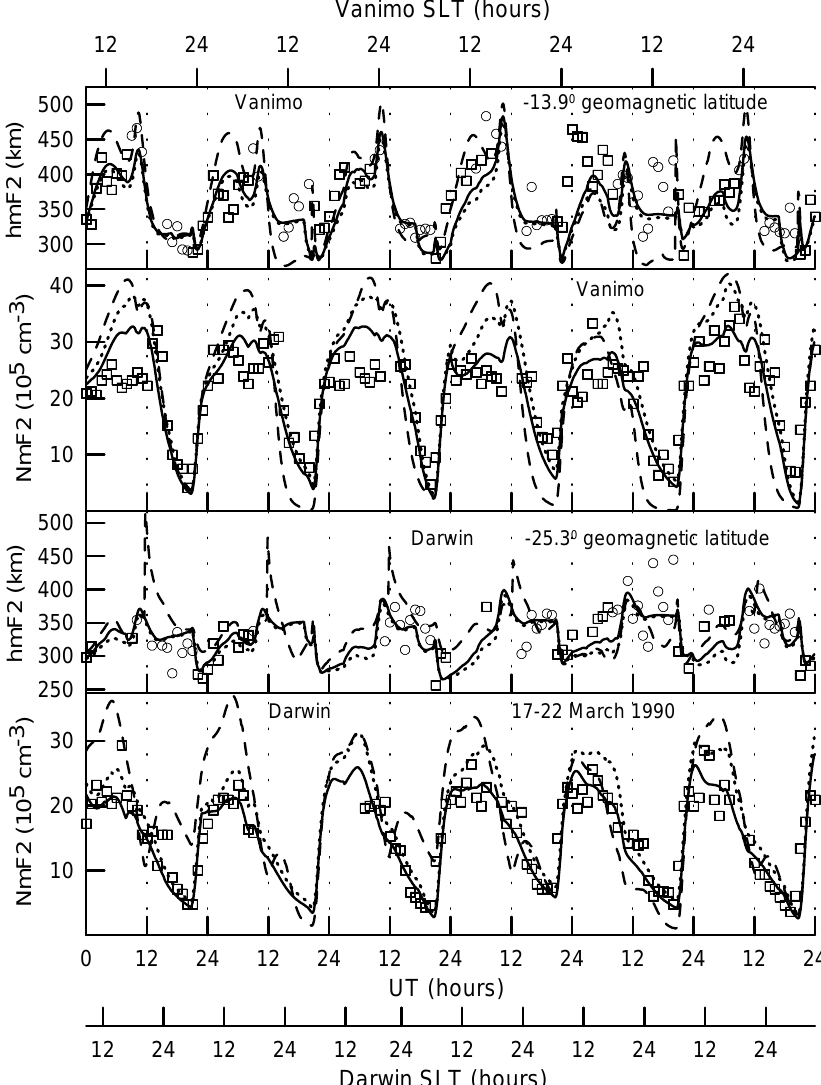
Fig. 3 Fig. 3. Observed (squares and circles) and calculated (lines) Nm F2 and hm F2 above the Darwin (two lower panels) and Vanimo (two upper panels) ionosonde stations during 17–22 March 1990. The relations between hm F2 and the measured values of M(3000)F2, fo f2, and fo E (see Sect. 3) are used to determine the values of hm F2, when the measured values of fo E are acceptable (squares) and not acceptable (circles). The results obtained from the model of the ionosphere and plasmasphere, using E eff , based on the uncorrected storm-time zonal electric 3 field given by the dashed line in Fig. 2, the NRLMSISE-00 neutral temperature and densities, and the HWM90 wind as the input model parameters, are shown by the dashed lines. The solid lines show the results obtained from the model of the ionosphere and plasmasphere, using the combinations of E eff , based on the corrected zonal electric field given by the solid line in Fig. 2, the corrected NRLMSISE-00 3 neutral densities, and the corrected neutral wind (see Sect. 4.1.1). The dotted lines show the results from the model with the same values of E eff , the HWM90 wind, and the NRLMSISE-00 neutral densities, as for the solid lines, when vibrationally excited N 2 and O 2 are not 3 included in the loss rate of O + ( 4 S)